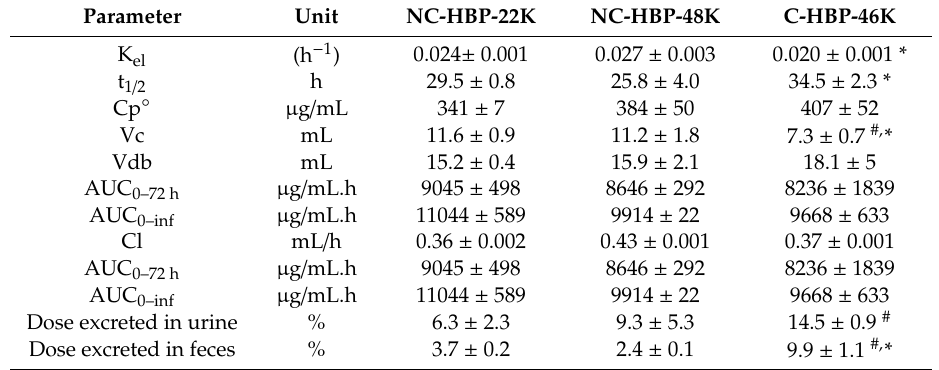
Figure 3. Plasma concentration versus time profile of 89 Zr-conjugated HBPs after intravenous administration in rats. Plasma concentrations were normalised to a dose of 15 mg / kg to allow direct comparison of the plasma profiles for each polymer. Data are shown as mean ± SD ( n = 3 rats, except NC-HBP-48K where n = 2 rats and data are represented as mean ± range). Table 2. Pharmacokinetic parameters of HBPs after intravenous administration to rats at a dose of 15 mg / kg. Data are expressed as mean ± SD ( n = 3 rats, except for NC-HBP-48K where n = 2 ± range).